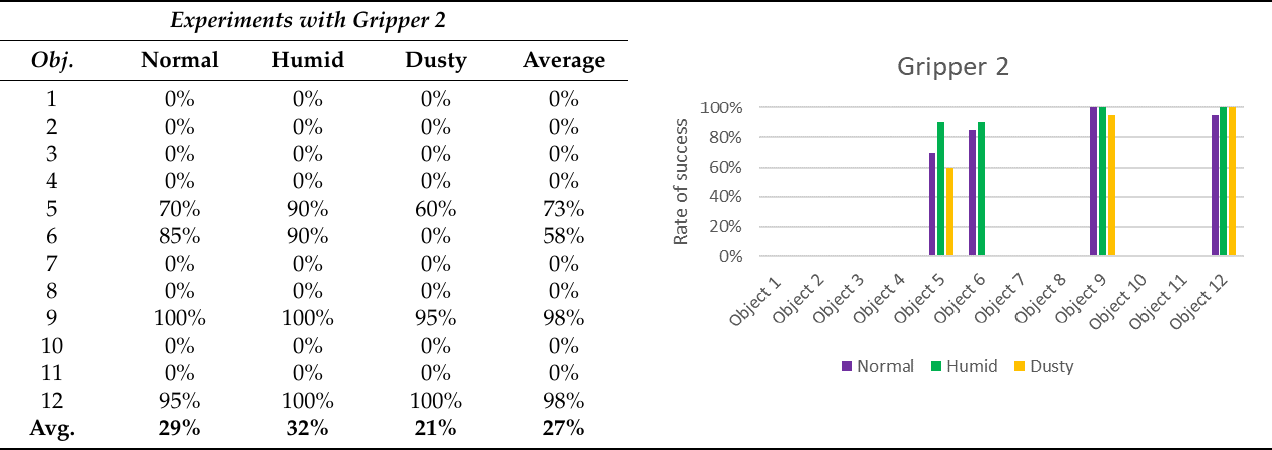
Table 3. Experiments with Gripper 2. On the left, the table with success rate for every object, in the last column, the average for every object is calculated, and at the end of the table, the average success rate for every environment is determined. On the right, the graphic representation of Table 3 is reported.